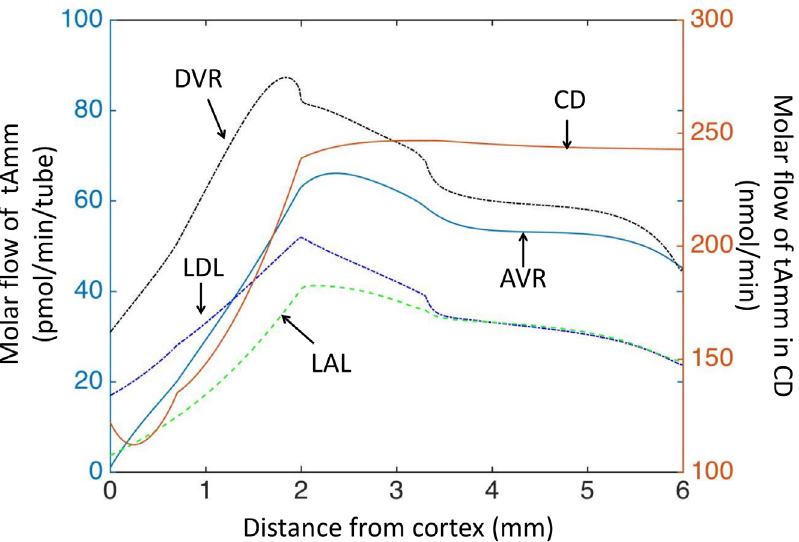
Fig 5. Model results: flow of total ammonia (tAmm) in each structure under baseline conditions. Ammonia is reabsorbed in OM ascending limb of the loops of Henle (decreased flow), and partly recycled into descending limbs (increased flow) or secreted into the collecting ducts. The increase in ammonia flow in the OM descending limbs is also due to tubular ammonia production. Please note the different scale for total flow in the collecting ducts, whereas flows are given per tube in nephron segments and blood